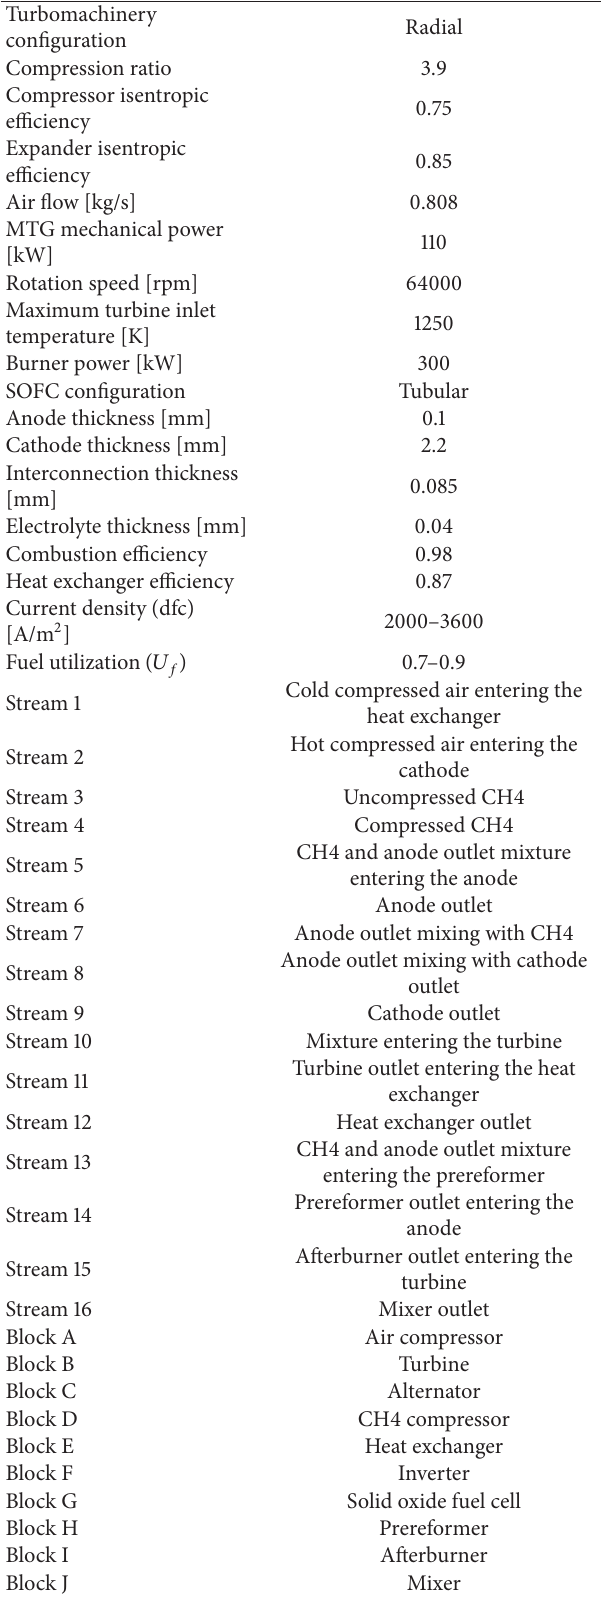
Table 1: Basic parameters of the components of the hybrid system and streams and blocks meaning in plant